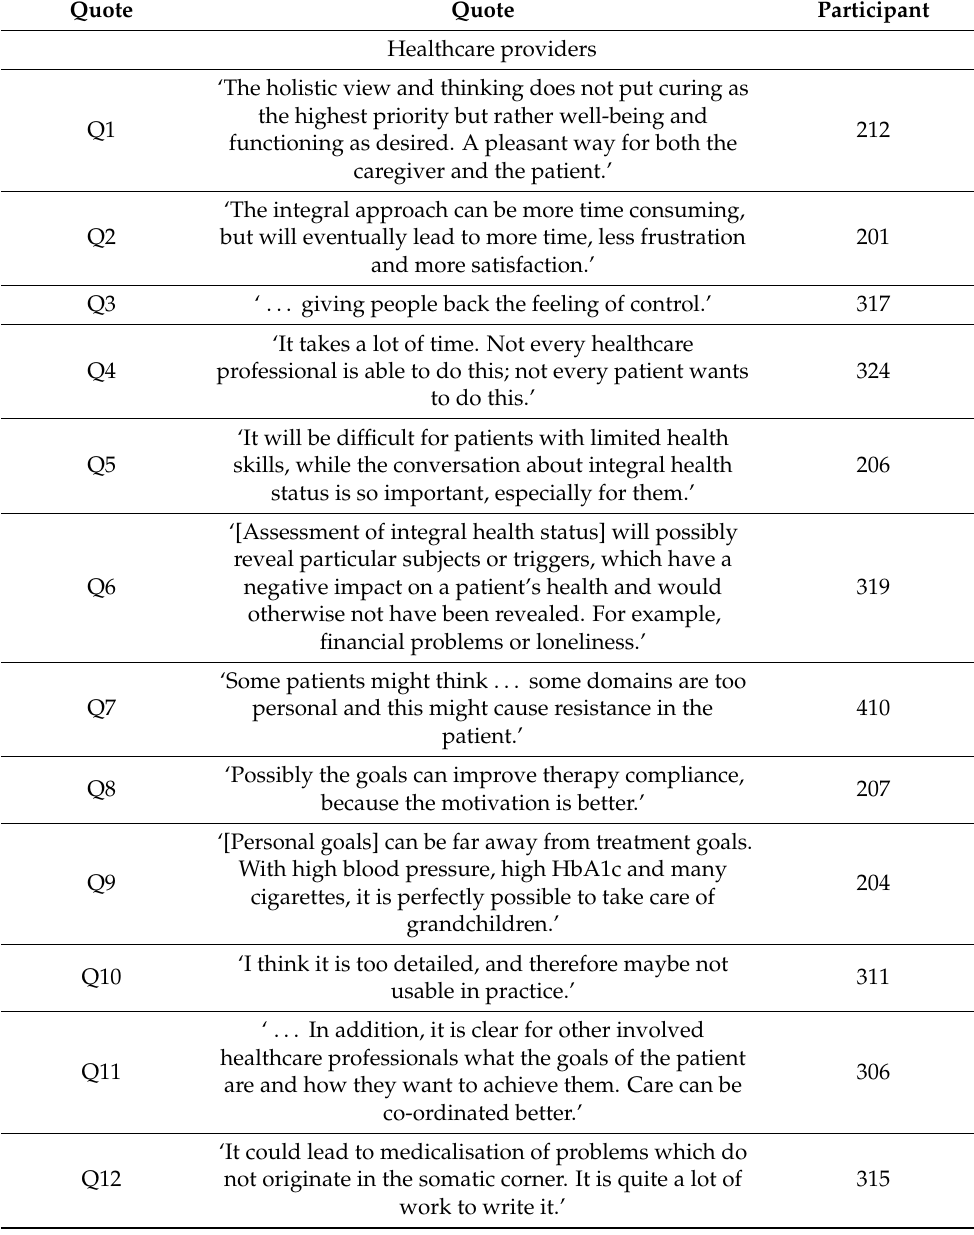
Table 5. Quotes from the online surveys with healthcare providers (from Phase 2) and individual interviews with patients with DM2, COPD, and/or CVD (from Phase